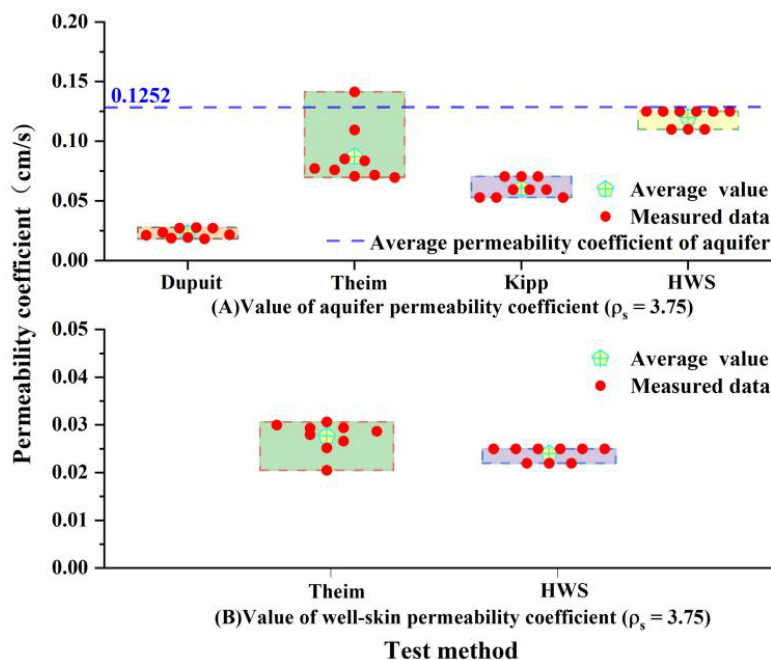
permeability coefficient under different methods).